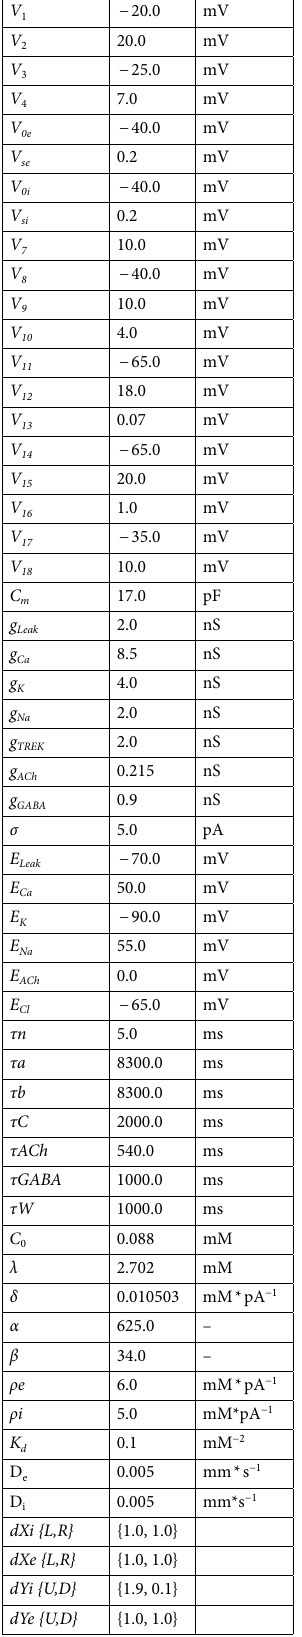
Table 2. Initial values and units of each of the biophysical parameters used in the